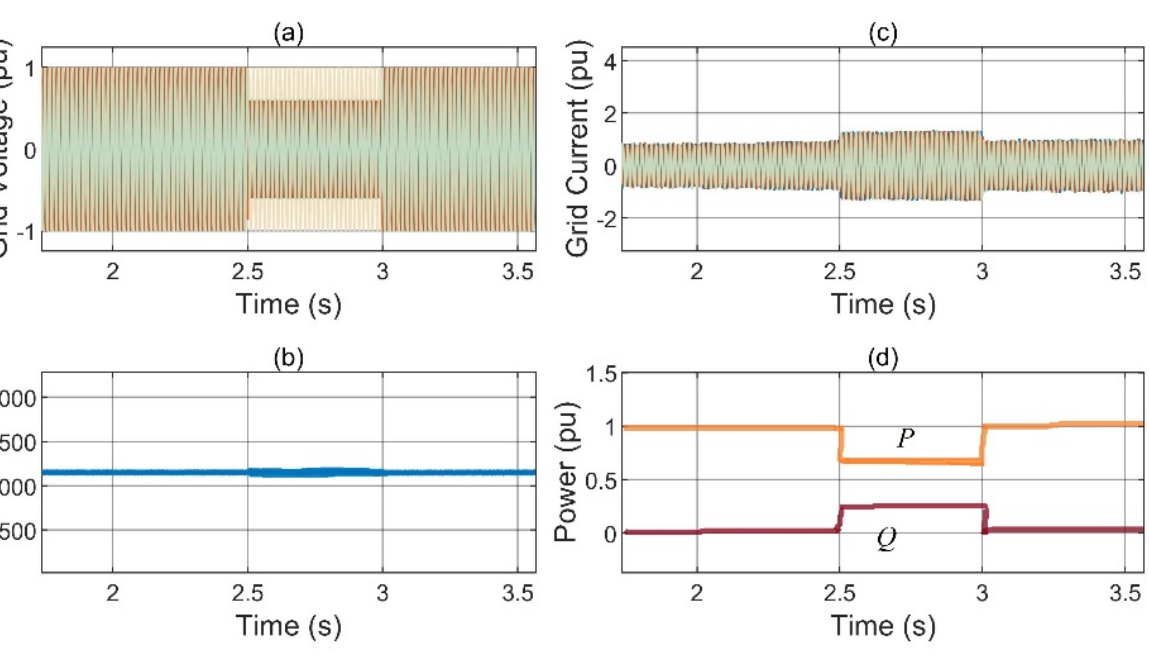
Figure 14. LVRT Performance of PI controller during symmetrical grid fault. ( a ) Grid voltage ( b ) Inverter current ( c ) DC-link voltage ( d ) Active and Reactive power